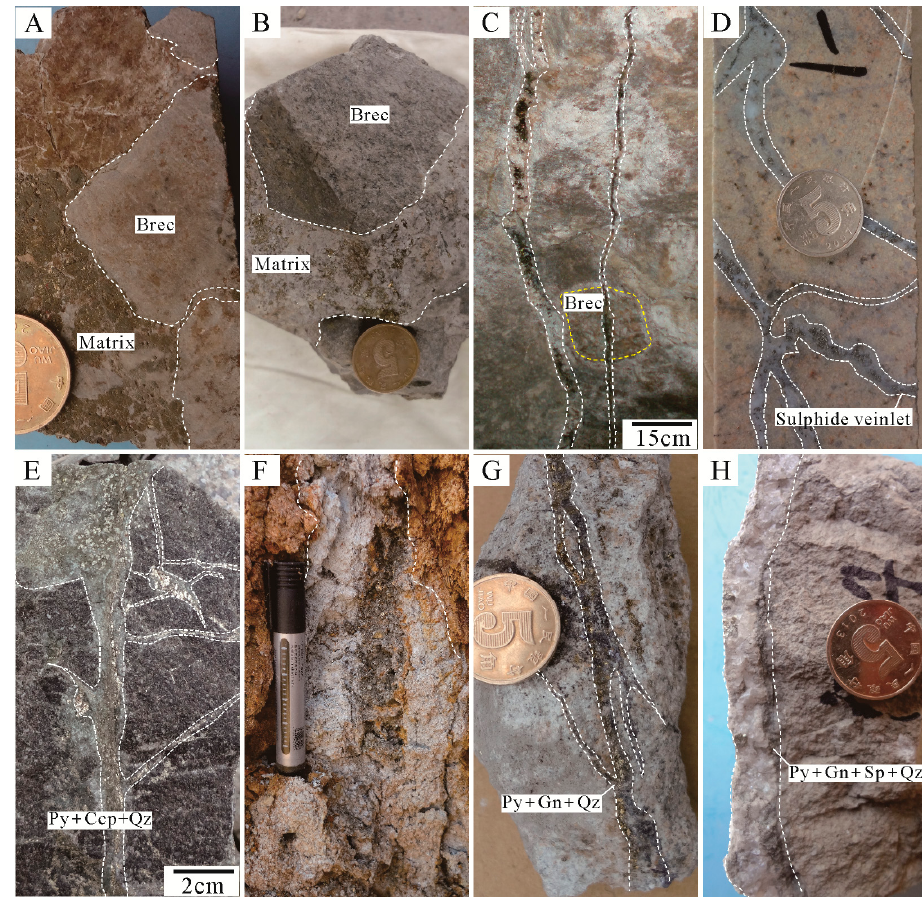
Figure 4. Photographs of ore from the Jinchang deposit. ( A – B ) Breccia-hosted ore; ( C ) breccia-hosted ore cross-cut by a quartz–pyrite–chalcopyrite vein; ( D ) veinlets and stockwork–vein mineralization; ( E ) quartz–pyrite–chalcopyrite veinlet; ( F ) fault–controlled orebody; and ( G , H ) quartz–pyrite–galena–(sphalerite) vein. Abbreviations: Brec, breccia; Qz, quartz; Py, pyrite; Ccp, chalcopyrite; Gn, galena; Sp, sphalerite.